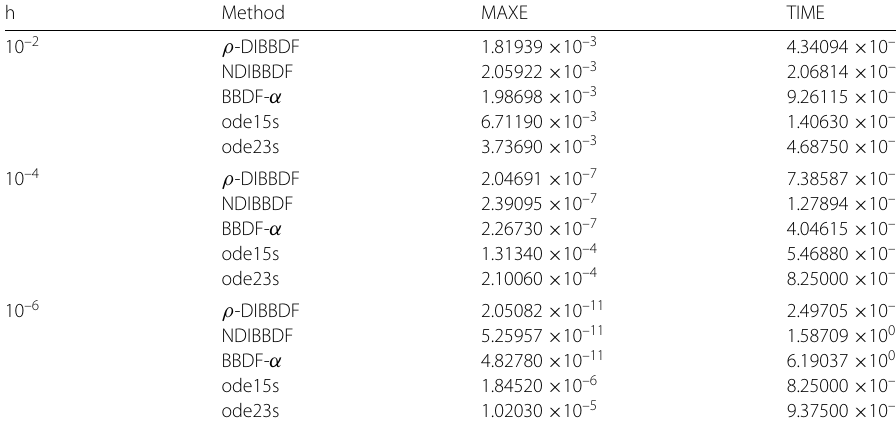
Table 5 Numerical results for concentration of drug in Model B—Compound